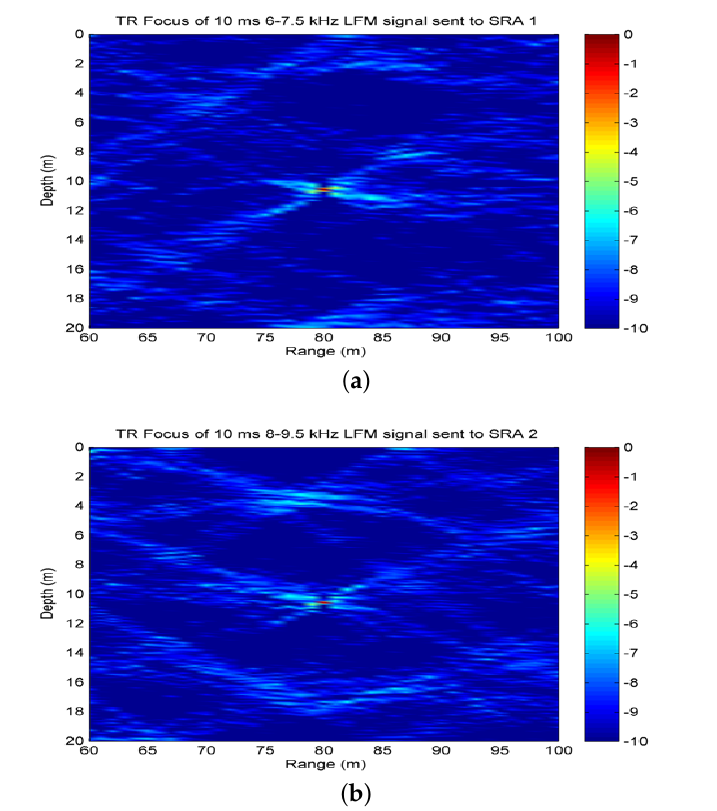
Figure 3. Time-reversal focusing with 10 ms LFM signals: ( a ) 6–7.5 kHz signal transmitted by SRA1; ( b ) 8–9.5 kHz signal transmitted by SRA2. Table 2. Resolution of time-reversal